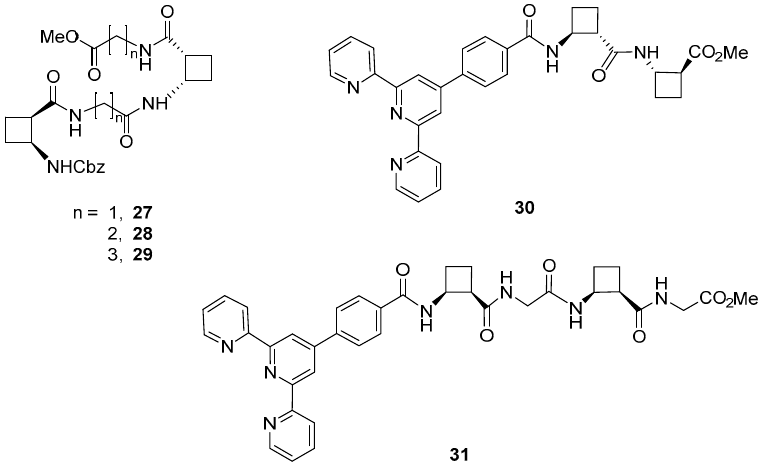
Figure 20. Chemical structures of hybrid peptides 27 – 29 and terpyridine-conjugated peptides 30 and 31 .